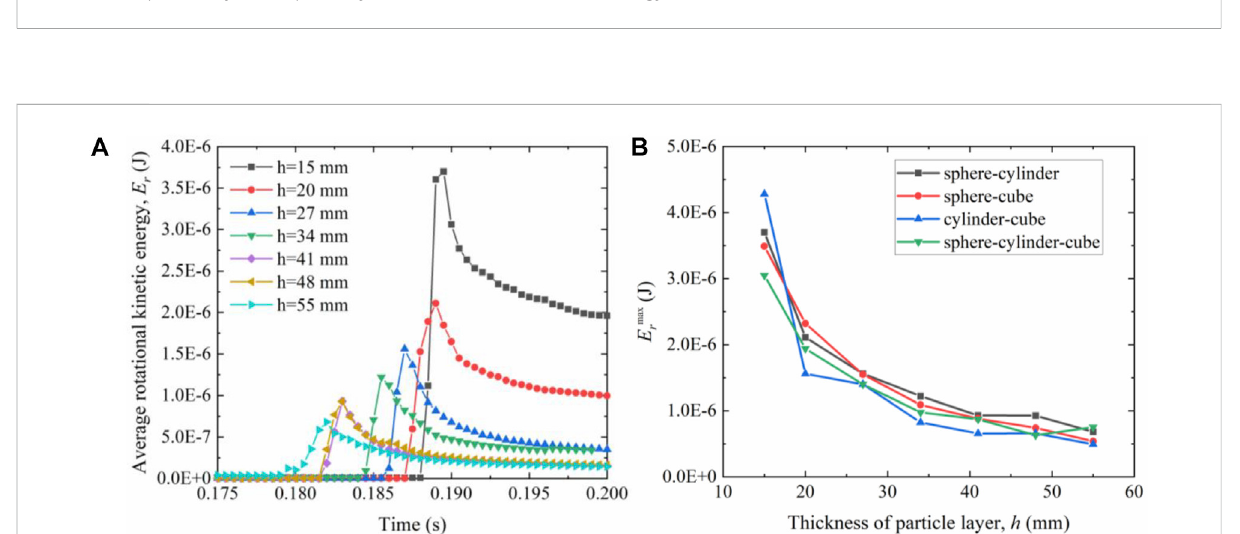
FIGURE 14 Evolution and comparison of the rotational kinetic energy for the rockfall impacting against the granular material of buffering with different thickness of particle layer: (A) sphere-cylinder; (B) rotational kinetic energy of